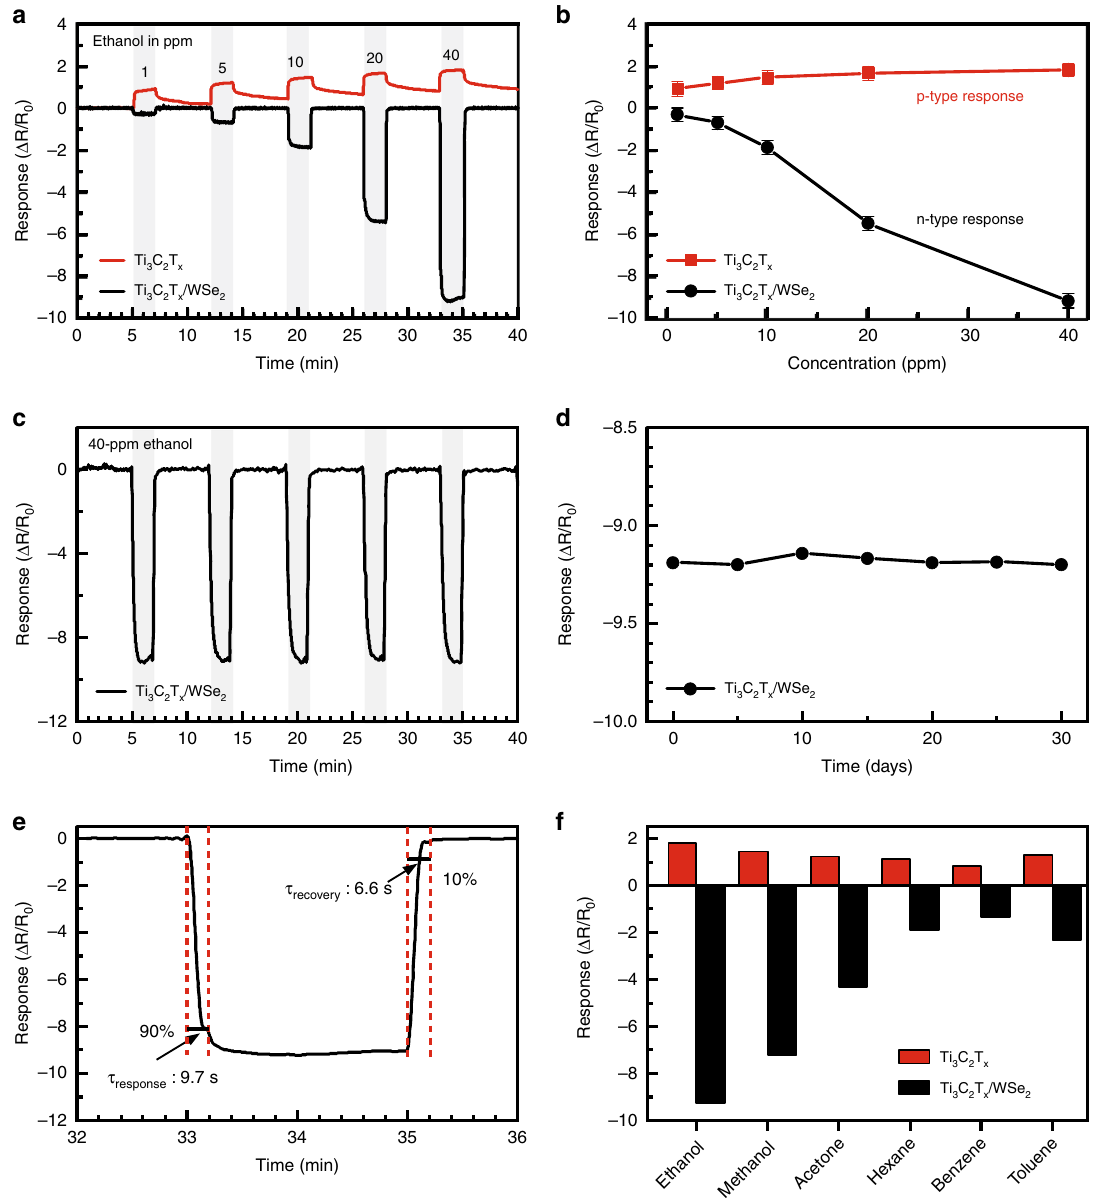
Fig. 4 Sensing characteristics of MXene-based VOC sensors. a Real-time sensing response of Ti 3 C 2 T x and Ti 3 C 2 T x /WSe 2 gas sensors upon ethanol exposure with concentrations ranging from 1 to 40 ppm. b Comparison of gas response as a function of ethanol gas concentrations for Ti 3 C 2 T x and Ti 3 C 2 T x /WSe 2 sensors. c Cycling performance of Ti 3 C 2 T x /WSe 2 gas sensors in response to ethanol at 40 ppm level. d Long-term stability of response over a month under 40 ppm of ethanol for Ti 3 C 2 T x /WSe 2 sensor. e Response and recovery times calculated for 40 ppm of ethanol. f Selectivity test of the Ti 3 C 2 T x and Ti 3 C 2 T x /WSe 2 sensors upon exposure to various VOCs at 40